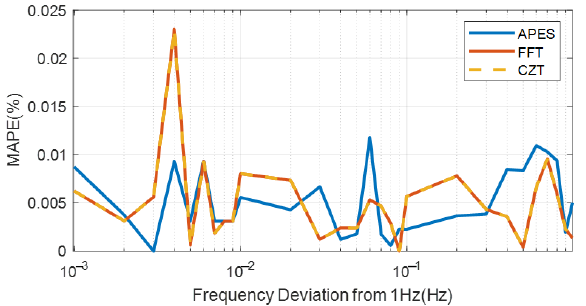
Figure 2. Single-tone frequency estimation error vs. different frequency position. The blue solid curve, the red solid curve, and the yellow dash curve are the results obtained by adaptive amplitude and phase estimation (APES), fast Fourier transform (FFT), and chirp z-transform (CZT), respectively.